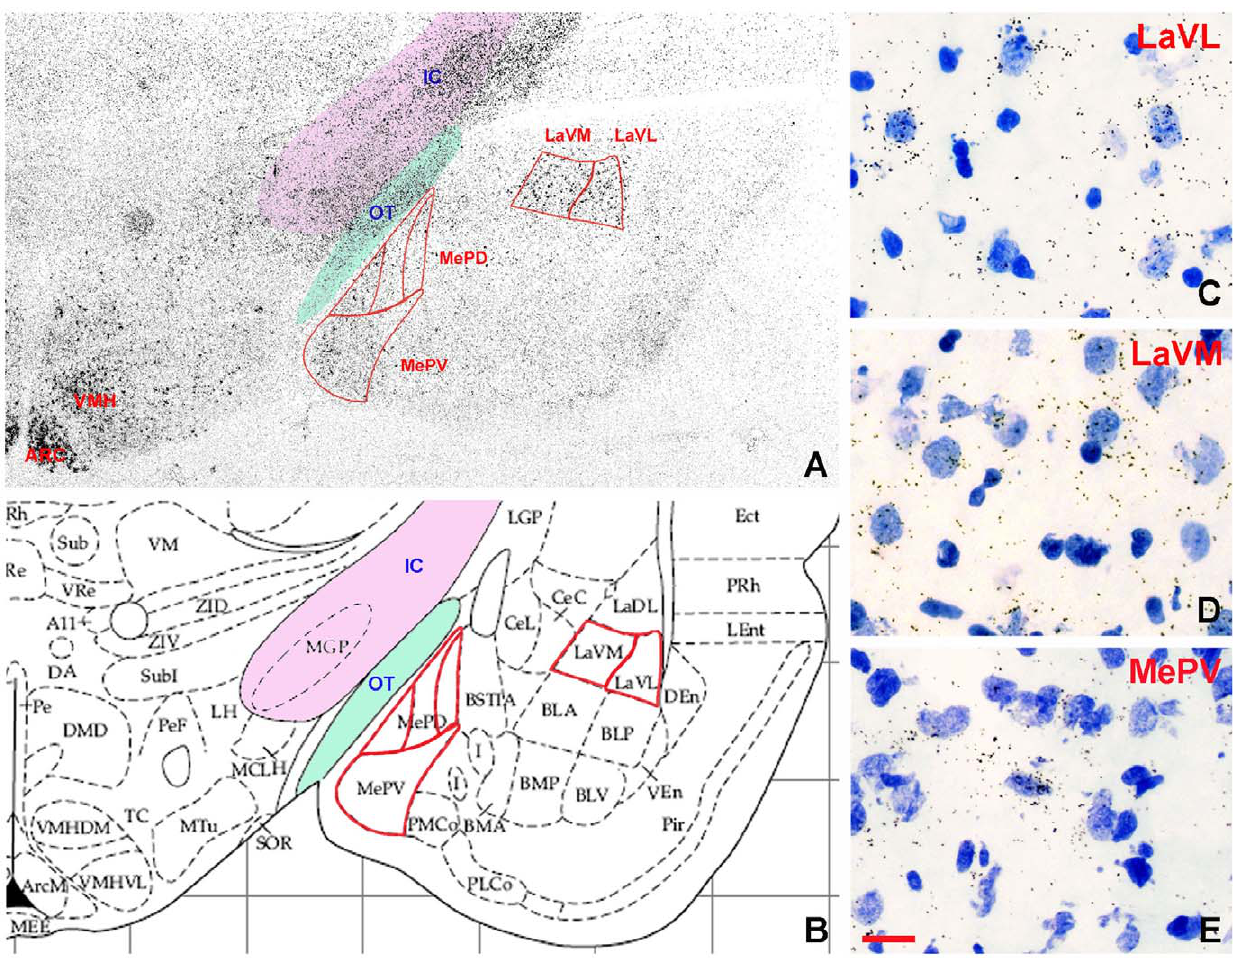
Figure 3. Insitu hybridization detection of GHSR mRNA in the rat amygdala. The autoradiographic detection of the isotopic in situ hybridization probe to GHSR mRNA revealed GHSR mRNA expression in distinct neurons of the amygdala. Note in A that the highest levels of expression could be observed in the ventrolateral (LaVL) and ventromedial (LaVM) parts of the lateral amygdaloid nucleus and in the posteroventral part of the medial amygdaloid nucleus (MePV). The parcellation and nuclear structure of the amygdala is shown in B. Also note the heavy GHSR mRNA signal in the arcuate (ARC) and ventromedial (VMH) nuclei. High-power photomicrographs (C–E) were amplified from various regions of the amygdala shown in A (cresyl violet counterstaining). Scale bars=500 m m in A and B and 13 m m in